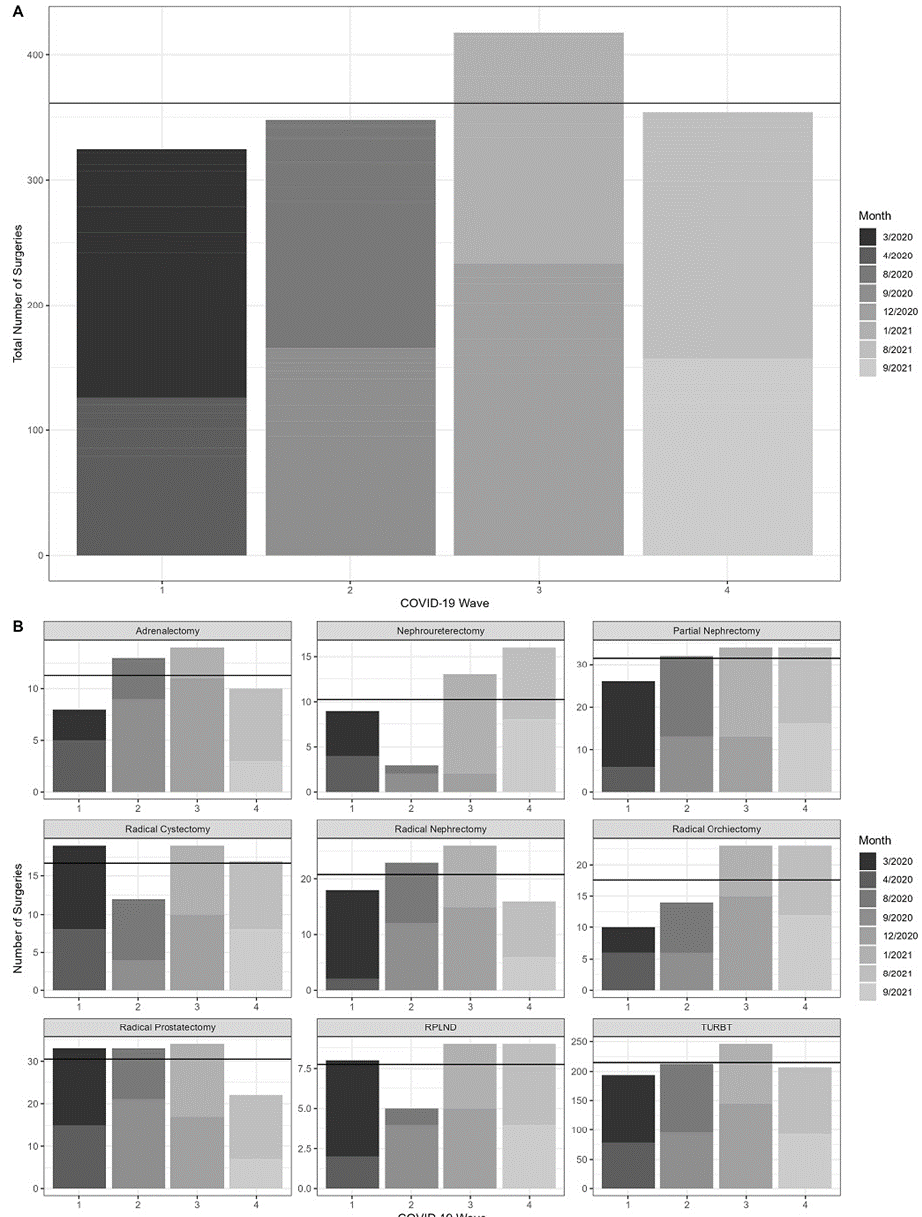
Figure 5. ( A , B ) Monthly urologic surgery volumes per COVID-19 wave and subgroup analysis by surgery type. The horizontal black line indicates the overall mean number of